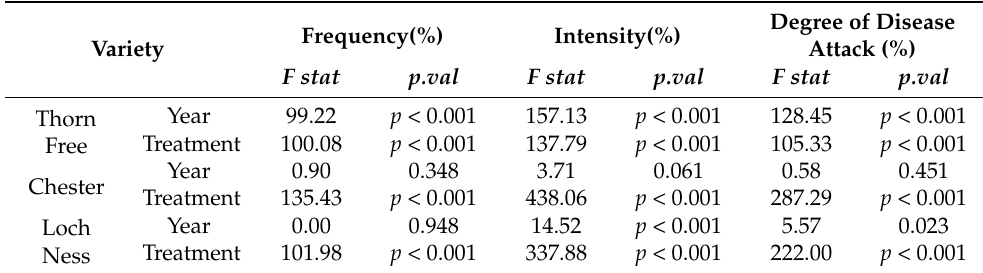
Table 3. Variant interactions with blackberry varieties for a period of two years (2018–2019) after ANOVA analysis ( p <